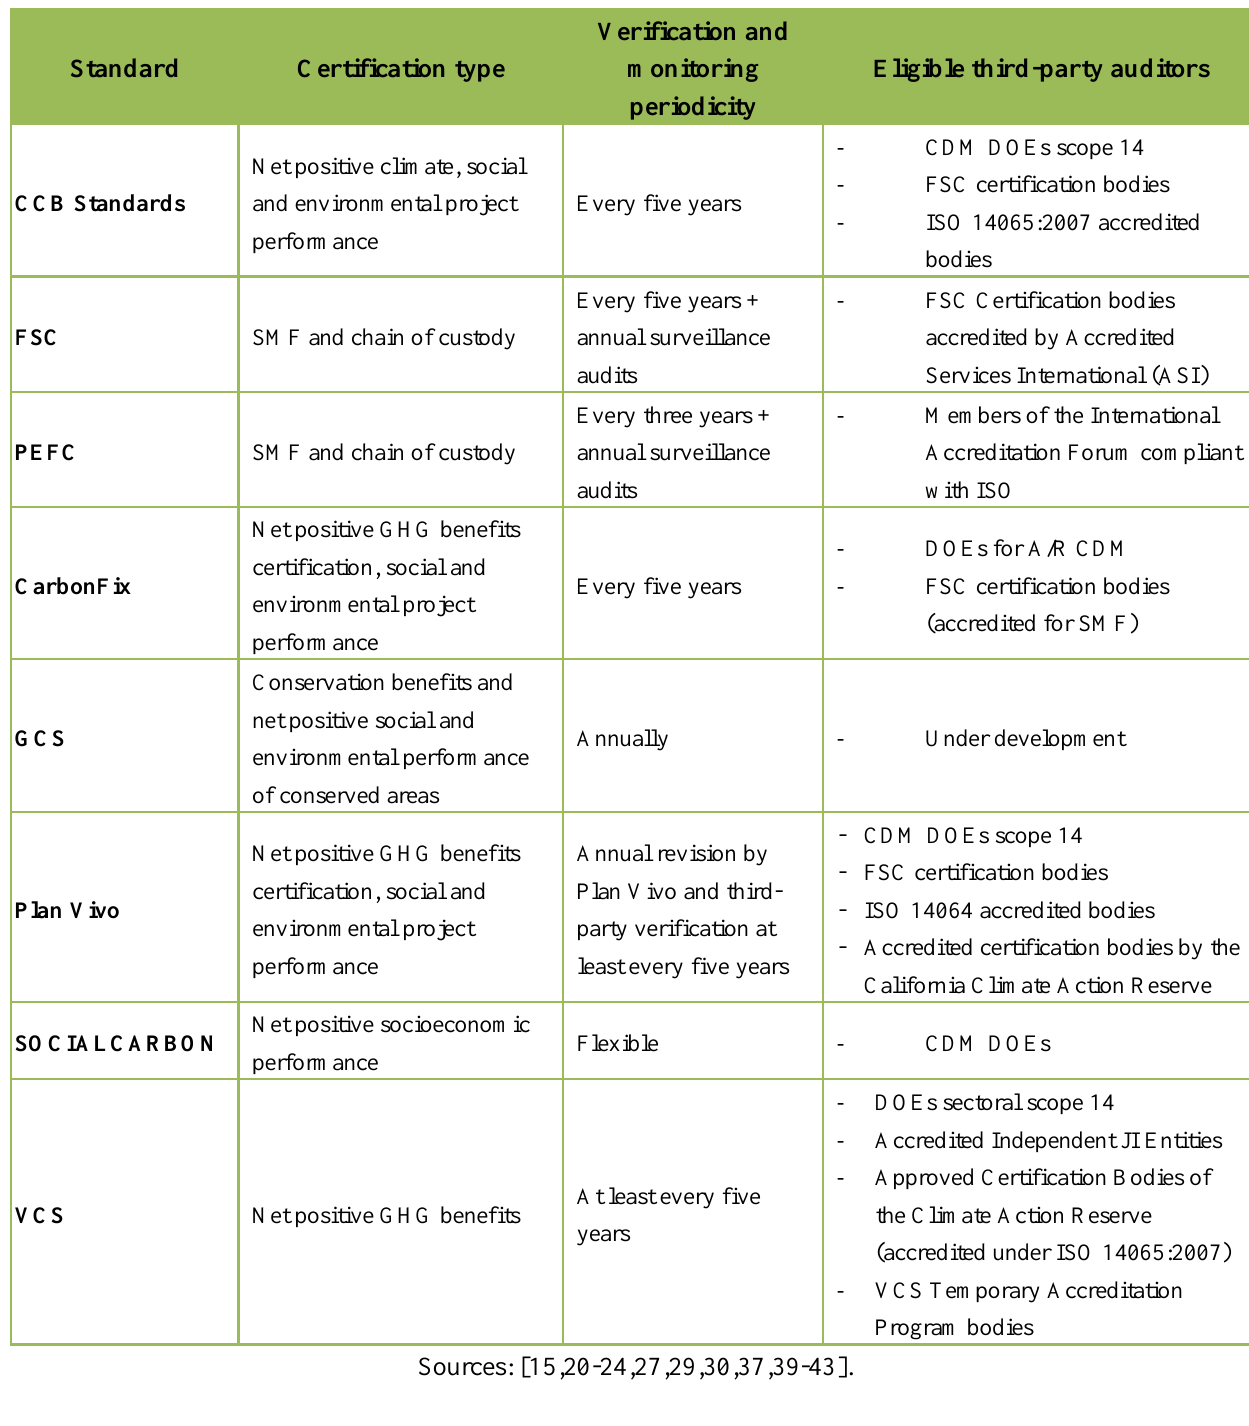
Table 6. Standards’ certification